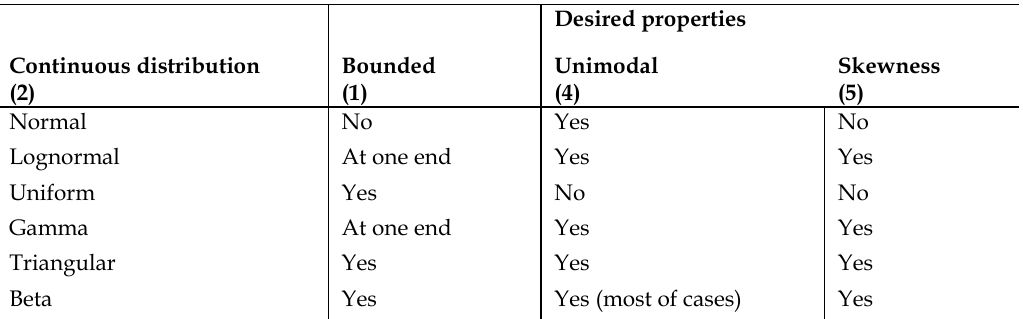
Table 3. Candidate probability distributions and their properties (adapted from Back et al., 2000)